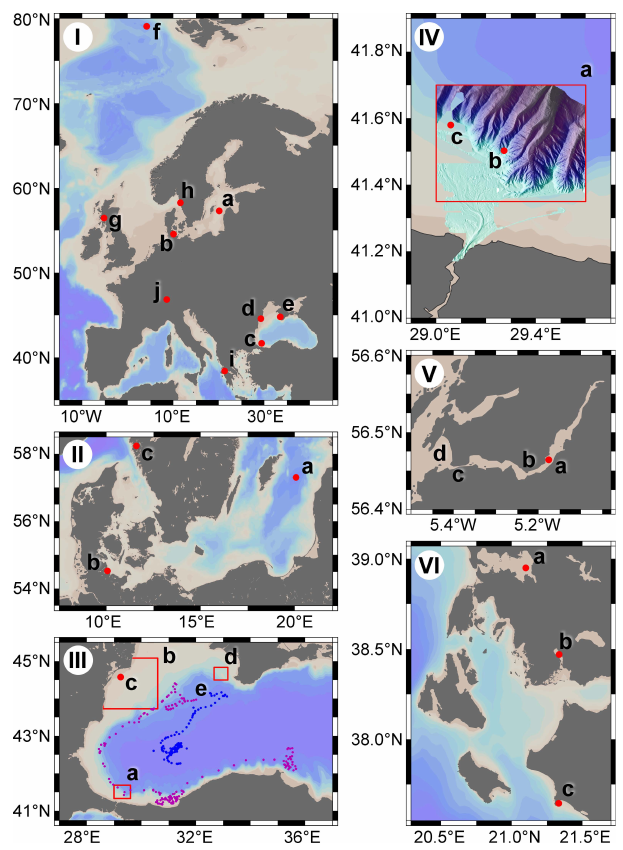
Fig. 1. Panel I, overview of study area: (Ia) Gotland Basin, (Ib) Eckernförde Bay/Boknis Eck, (Ic) Bosporus outlet, (Id) north- western Black Sea shelf, (Ie) western Crimean shelf, (If) Fram Strait/HAUSGARTEN observatory, (Ig) Loch Etive, (Ih) Koljoe Fjord, (Ii) Ionian Sea lagoons and embayments, (Ij) Swiss lakes. Panel II, Baltic Sea and adjacent study area: (IIa) Gotland Basin observatory, (IIb) Eckernförde Bay/Boknis Eck time-series station, (IIc) Koljoe Fjord observatory. Panel III, Black Sea study area: (IIIa) Bosporus outlet study area, (IIIb) northwestern shelf study area, (IIIc) Portita Bay/northwestern shelf observatory (IIId) west- ern Crimean shelf study area, (IIIe) deployment area of NEMO Floats 144 and 145 (profiling locations/drift track: blue and purple dots). Panel IV, Bosporus outlet study area: (IVa) coring and water sampling area, (IVb) core MSM015-192, (IVc) core MSM015-311. Panel V, Loch Etive study area: (Va) Loch Etive cabled observatory, (Vb) Bonawe Sill, (Vc) “Falls of Lora” sill, (Vd) Ardmucknish Bay. Panel VI, Ionian Sea study sites: (VIa) Amvrakikos Gulf, (VIb) Ae- toliko Lagoon, (VIc) Katakolo